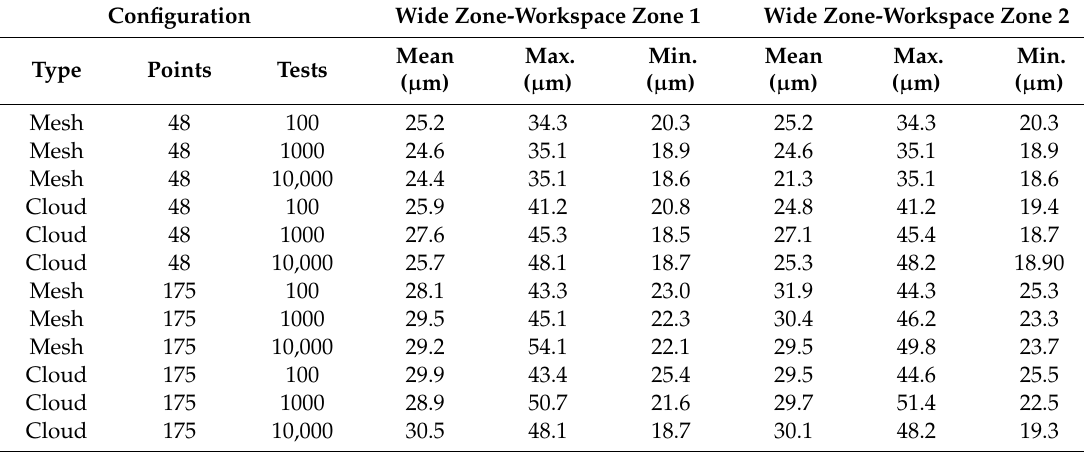
Table 4. Influence of design parameters on wide zone LT location area and after division of the MT